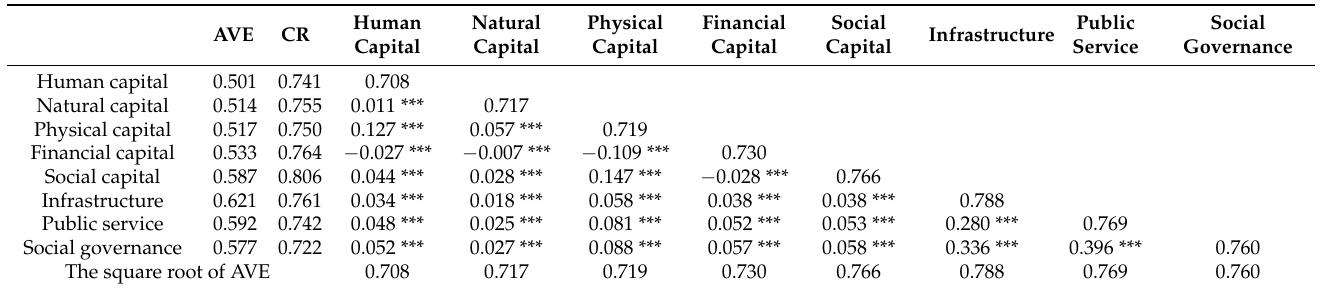
Table A2. Confirmatory factor analysis (CFA) of the discriminant validity.